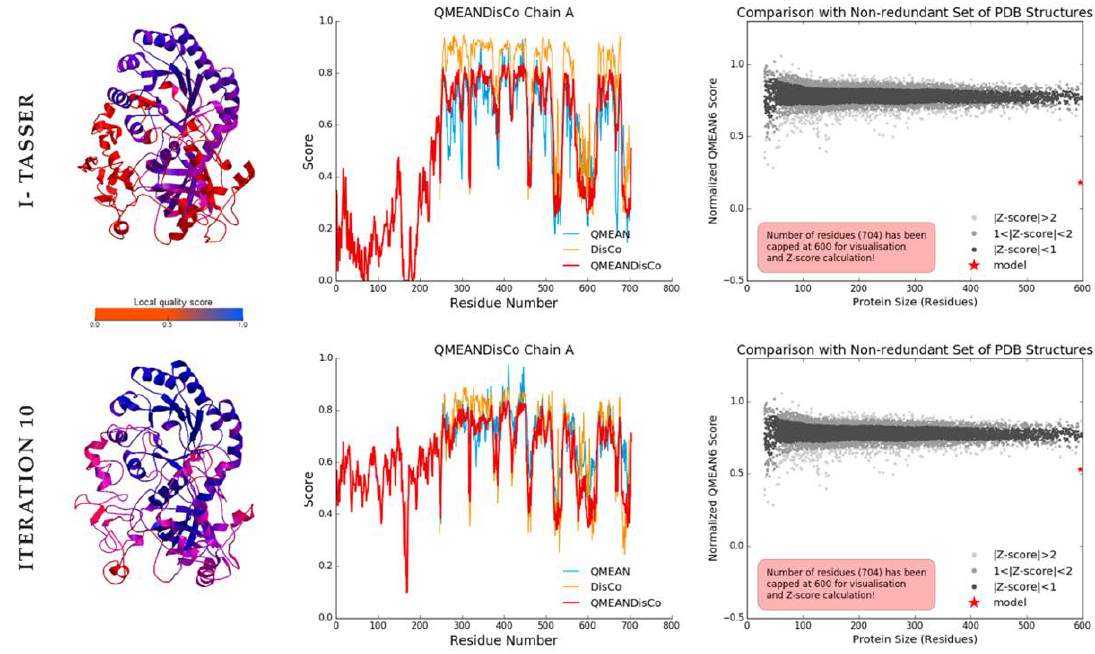
Figure 4. Comparison between the initial ODC model generated in I-Tasser against to iteration 10 model. Left—Evaluation of the three-dimensional model for local residues. Center—Plots by number of residues. Right—Value of the analyzed model compared to the QMeanDisCo3 validation set. Iteration number 10 was a great improvement of the